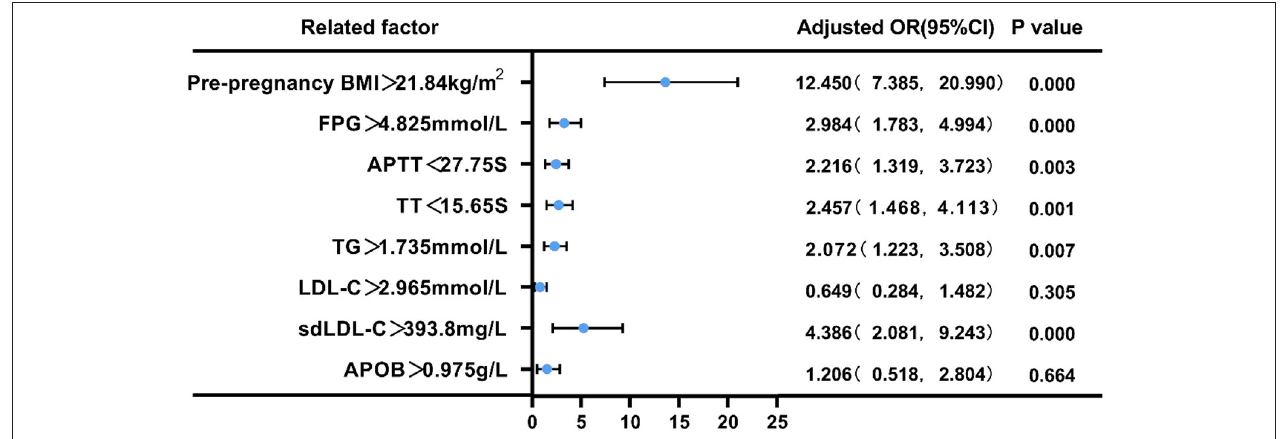
FIGURE 7 | Forest plot of the multivariate logistic regression analysis of pre-pregnancy BMI, FPG, APTT, TT,TG, LDL-C, sdLDL-C, APOB in pregnant women with